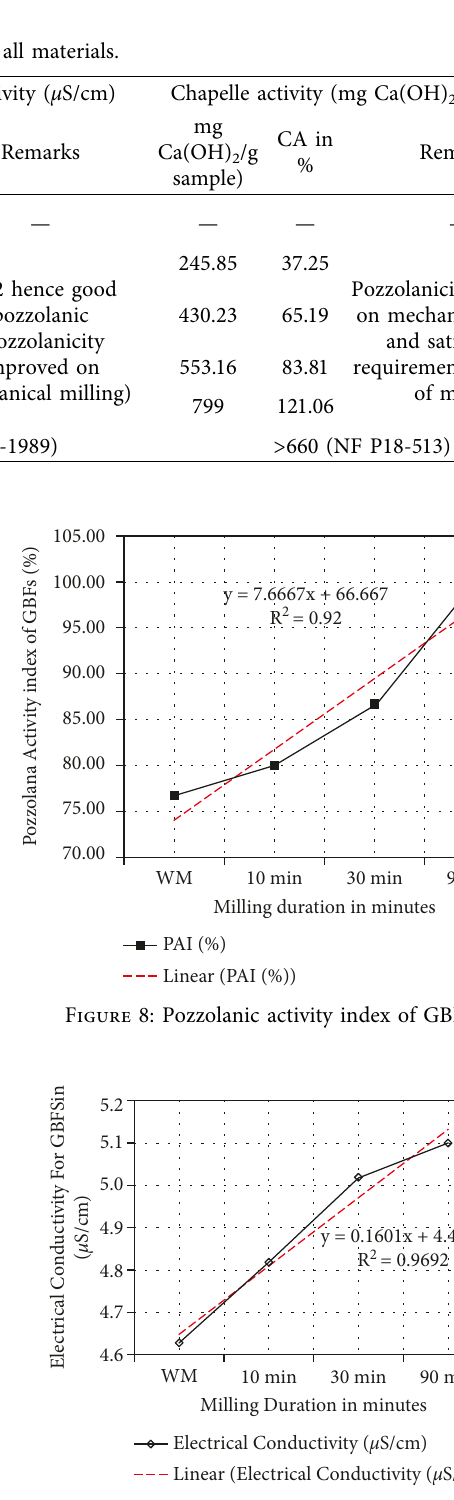
Figure 9: Electrical conductivity of GBFS for different grinding times.